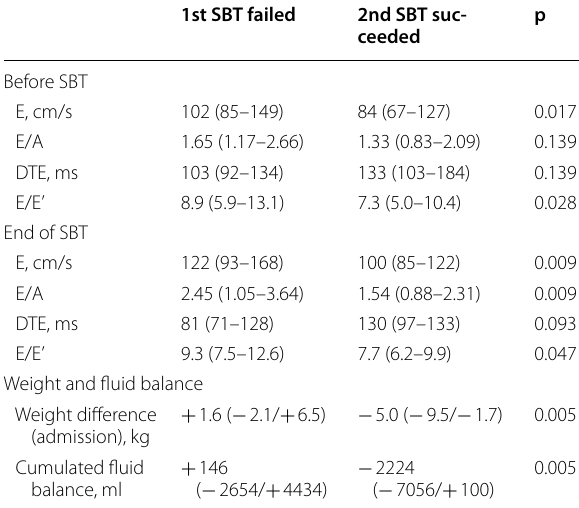
Table 1 Sub‑group of patients who failed the first SBT